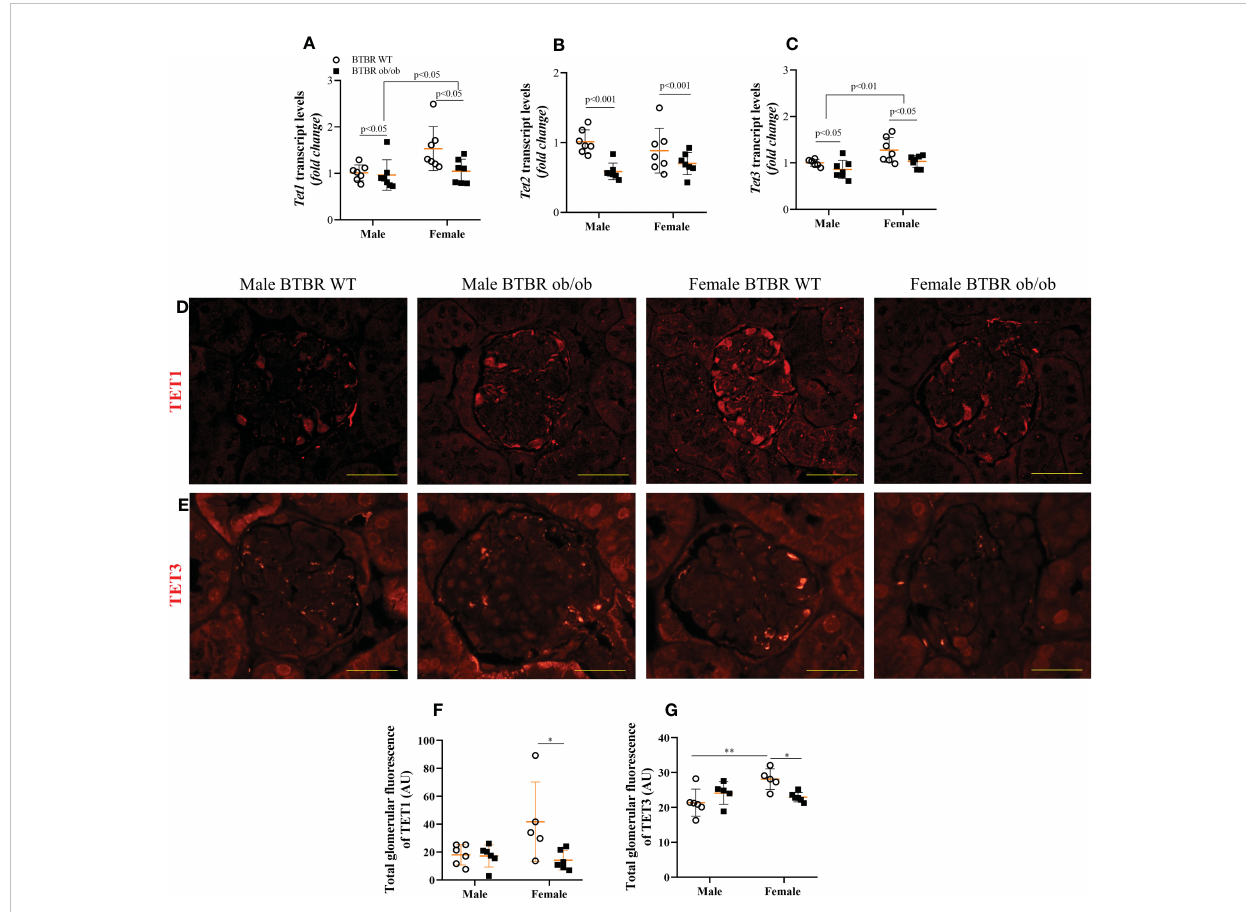
FIGURE 5 Obesity and diabetes negatively modulate TET protein expression in females. Effects of sex and metabolic condition in BTBR mice on Tet1 (A) , Tet2 (B) , and Tet3 (C) transcript levels and on total glomerular fl uorescence of TET1 (D, F) and TET3 (E, G) . The values are the mean±SD (n=5 - 7). Immuno fl uorescence images were captured using NIS-Elements software coupled to a light microscope equipped with a 40x objective at laser excitation of 543 nm (Eclipse 80i). Bars = 50 m m. WT, wild type; AU, arbitrary units; Tet1 , Tet Methylcytosine Dioxygenase 1; Tet2 , Tet Methylcytosine Dioxygenase 2; Tet3 , Tet Methylcytosine Dioxygenase 3. p values corresponding to the independent effect of metabolic condition or sex are speci fi ed in the graphs. **p<0.05 versus male BTBR WT; *p<0.05 versus female BTBR